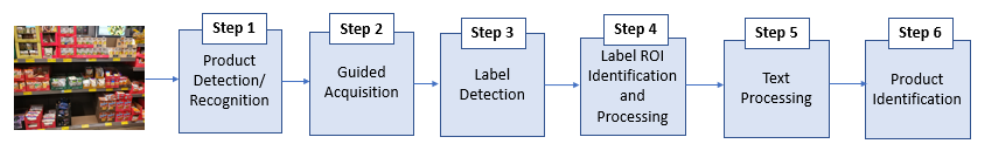
Figure 3. Conceptual pipeline of assisted retail product label